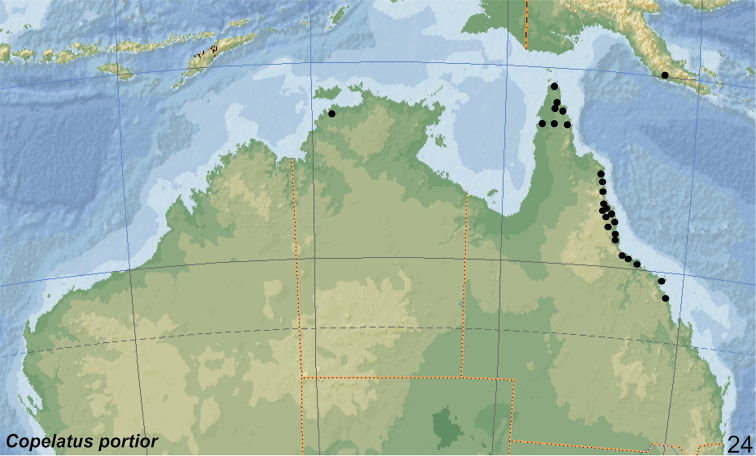
Distribution of Copelatus
portior.